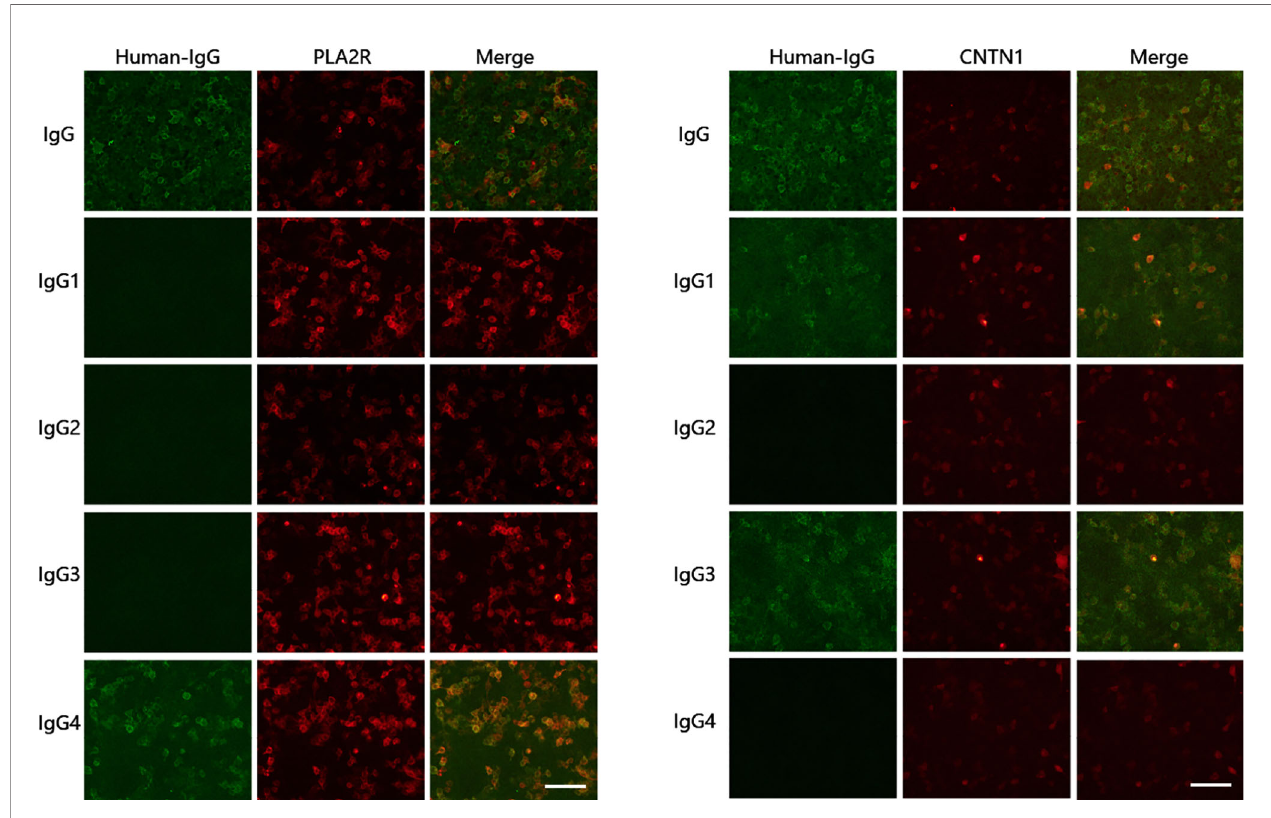
FIGURE 3 | Detection of anti-CNTN1 and anti-PLA2R antibodies and subclasses. Anti-CNTN1 antibody subclasses: IgG3(+), IgG1(+); serum anti-PLA2R antibody subclasses: IgG4(+). Scale bar = 100